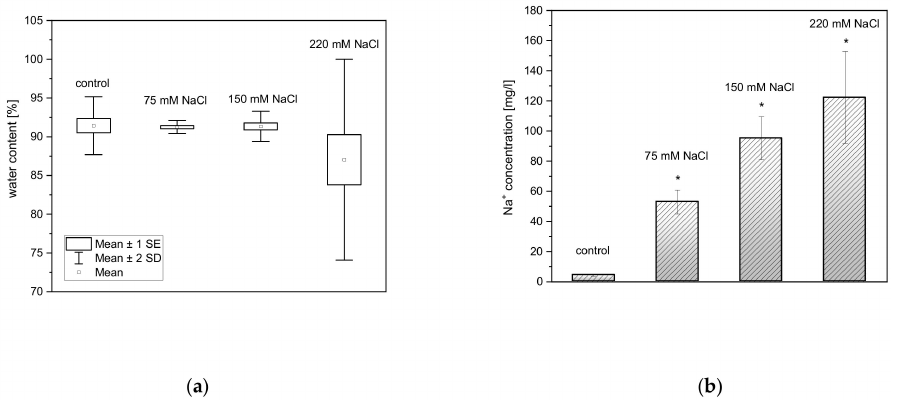
Figure 1. Water content of four-old-week rosettes of non- and salt-treated A. thaliana plants. Results are presented as box-and-whisker plots, showing mean and standard error at the 95% confidence level ( a ). Concentration of sodium ions accumulated in A. thaliana leaf rosettes after one-time treatment with 0, 75, 150, and 220 mM NaCl ( b ). Asterisks (*) indicate significant differences in Na + content between non- and salt-treated plants (ANOVA, p ≤